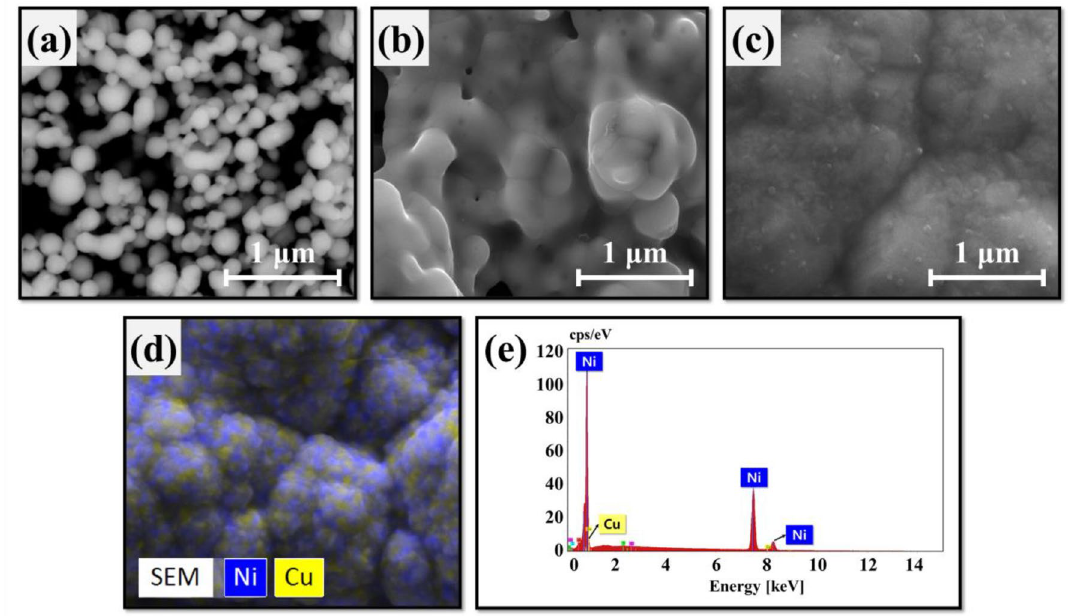
Figure 7. SEM analysis of an ( a ) IPL sintered Cu NPs electrode, ( b ) IPL sintered CPN electrode, and ( c ) Ni electroplated CPN electrode (S-16). ( d ) EDS mapping for a Ni electroplated CPN electrode and an ( e ) EDS spectrum for Ni electroplated CPN electrode